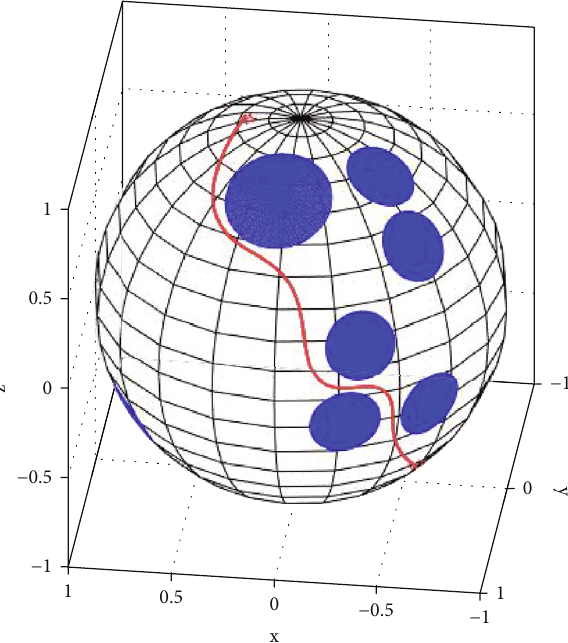
Figure 4: Trajectory of the infrared telescope vector in the celestial coordinate system of the cross-mutation grey wolf optimizer.